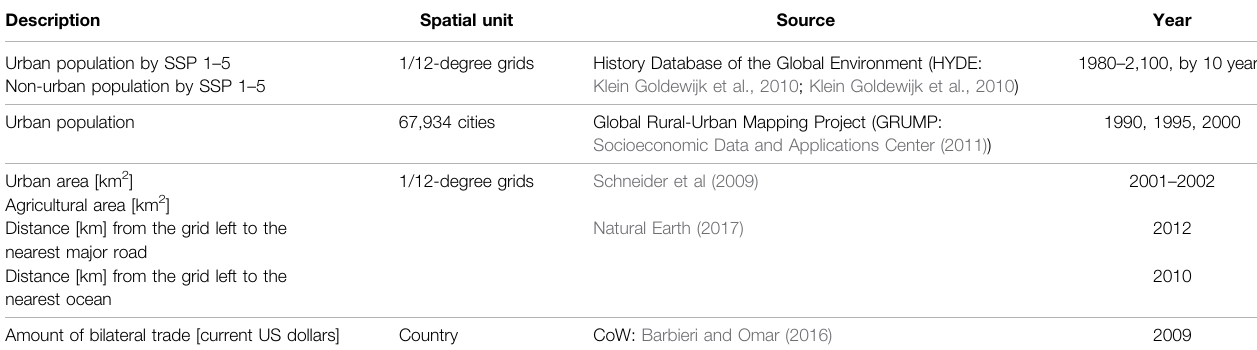
TABLE 1 | Auxiliary